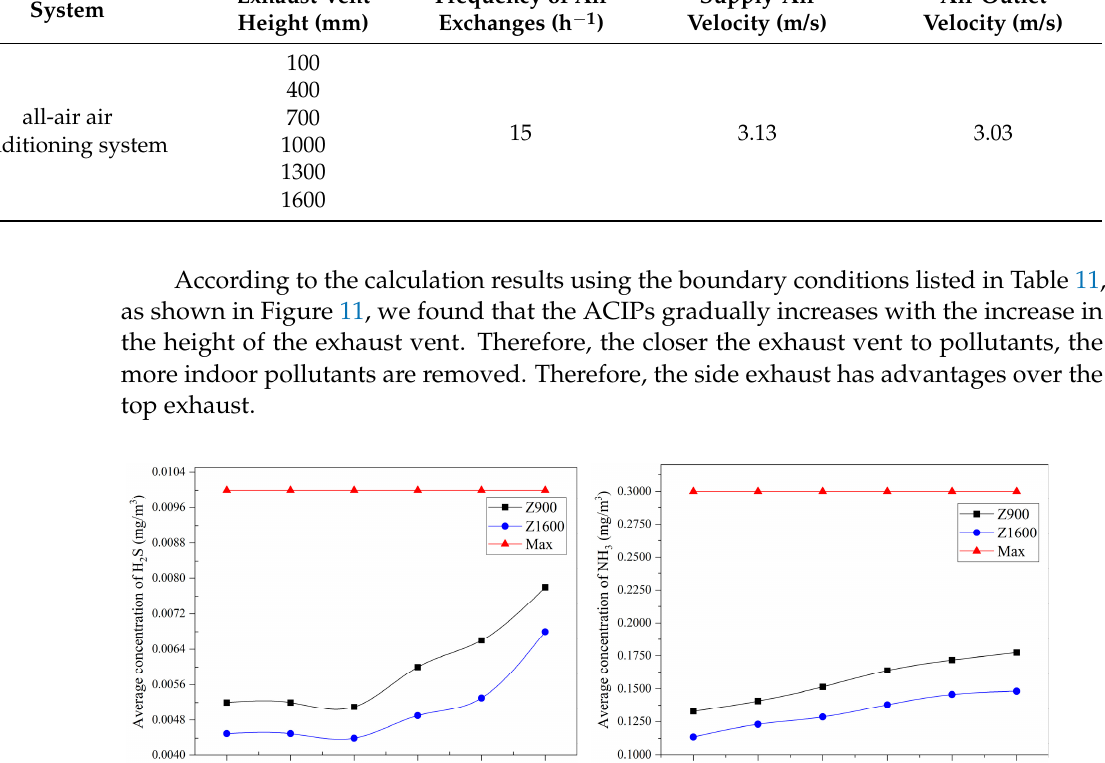
Table 12. Boundary conditions of side exhaust air for different frequencies of air exchanges.